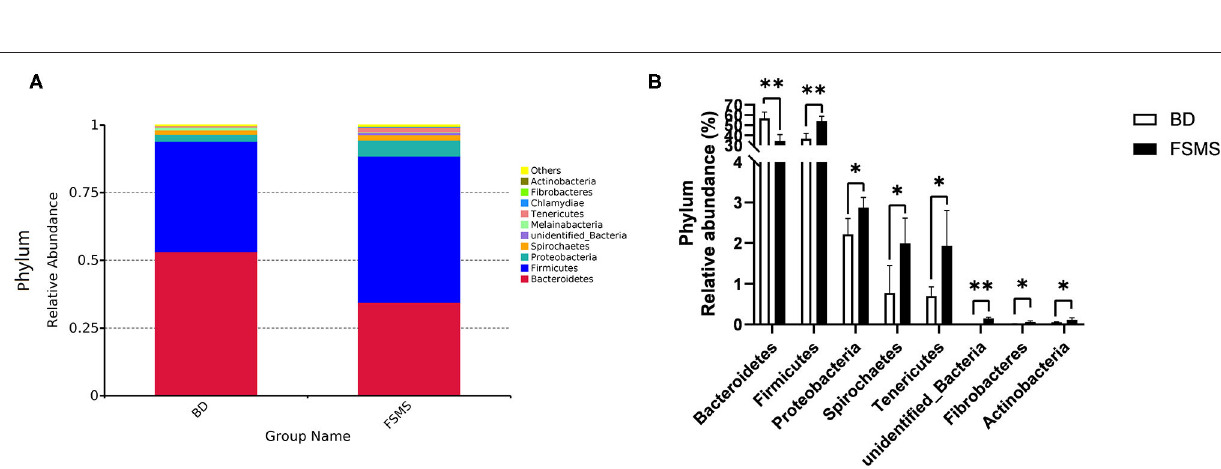
FIGURE 3 | Relative abundance of bacterial phylum in the colonic digesta of pigs (A) . Significant changed phyla in the colonic digesta (B) . Values were expressed as means ± SEM ( n = 6). Statistical differences were calculated by Duncan: * p < 0.05, ** p < 0.01.